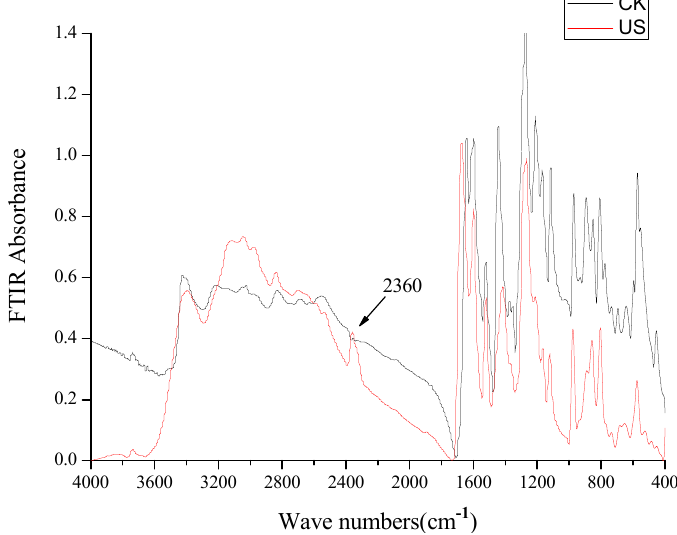
Figure 8. FT-IR spectra at different wave numbers (cm − 1 ) corresponding to caffeic acid treated by ultrasound (US) at − 5